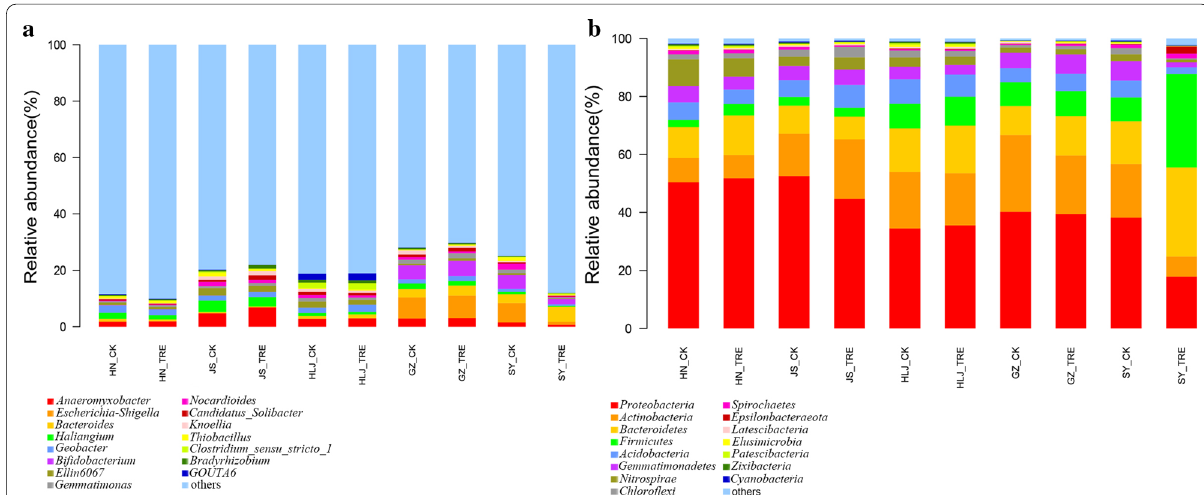
Fig. 1 Relative abundances (%) of bacterial composition (phyla and genera level) in BIO-treated and untreated soil samples at five rice paddy sites. a Relative abundance of the top 15 phyla among the BIO-treated soil samples. b Relative abundance of the top 15 genera among the BIO-treated soil samples. The HN_CK, HN_TRE, JS_CK, JS_TRE, HLJ_CK, HLJ_TRE, GZ_CK, GZ_TRE, SY_CK and SY_TRE represent BIO treated and untreated control at the five rice paddy sites in